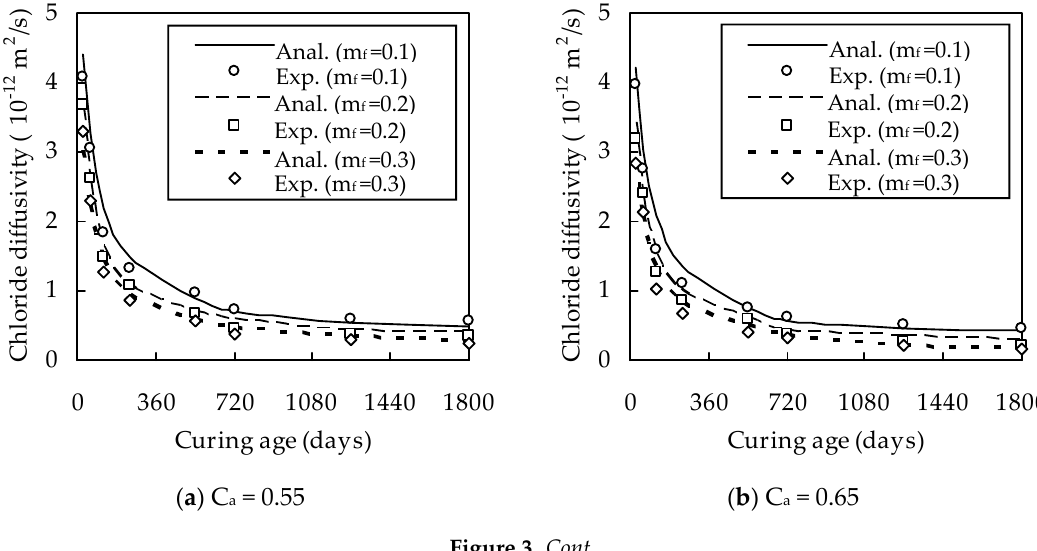
Figure 2. Variation of D cf with t for w/b = 0.4.